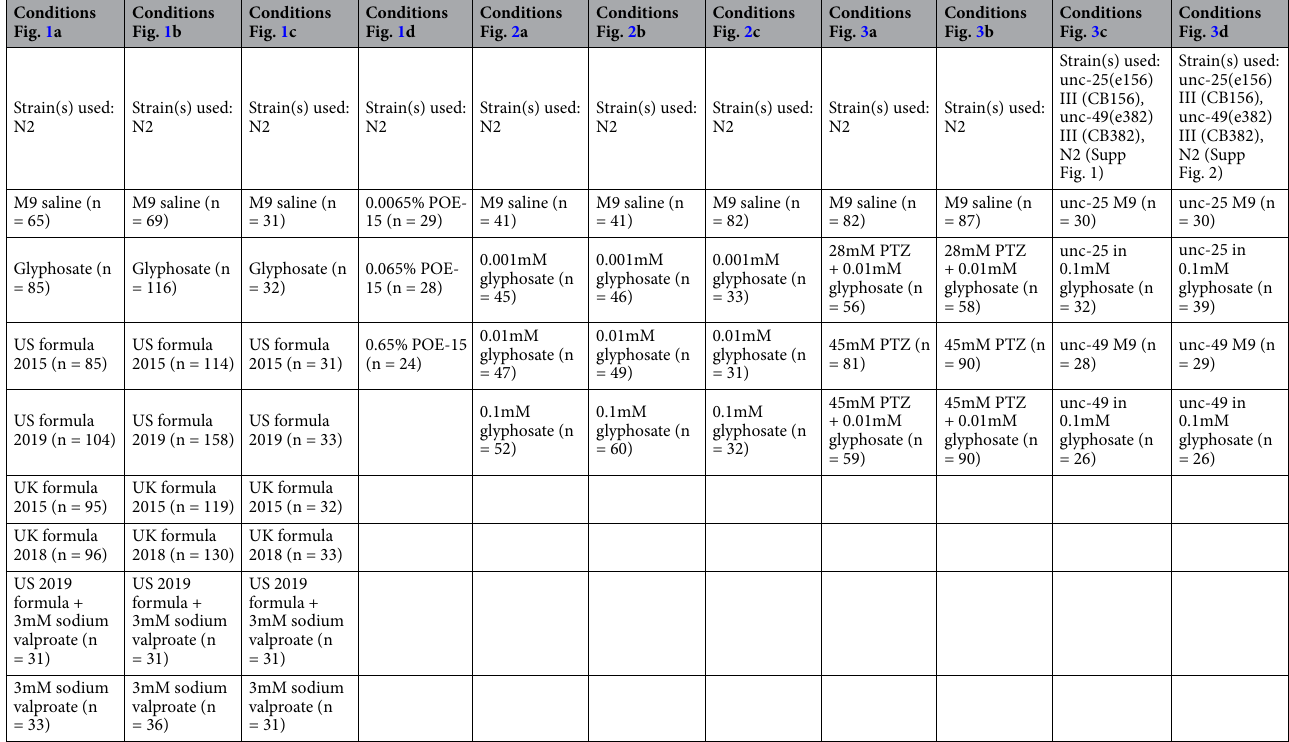
Table 1. All strains, conditions, and number of worms tested are organized by figure number and letter which corresponds to those in the main text. All Roundup conditions standardized to 0.1mM glyphosate for